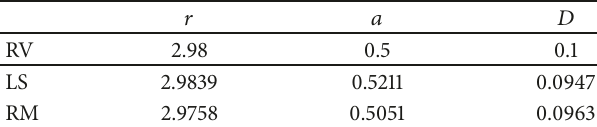
Table 1: The estimation result when the sample values are generated from rand initial value from 𝑡 = 1 to 𝑡 = 100000